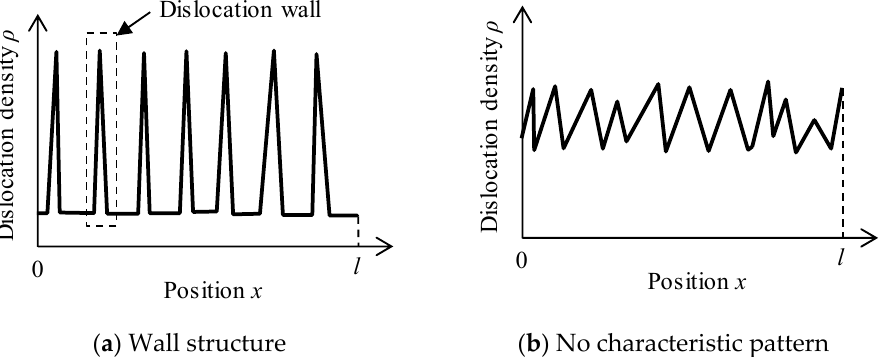
Figure 1. Schematics of typical dislocation density distributions ( ρ i ). ( a ): Aligned peaks with low- density areas in between, indicating formation of wall structure. ( b ): No self-organized dislocation pattern.